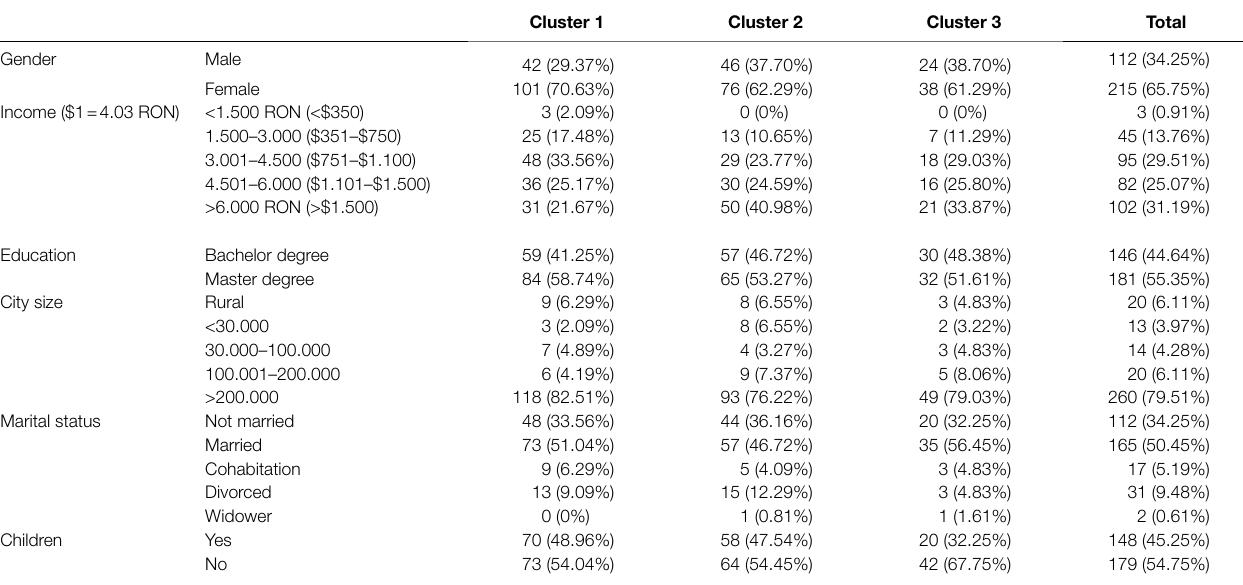
TABLE 6 | Socio-demographic and economic descriptors per